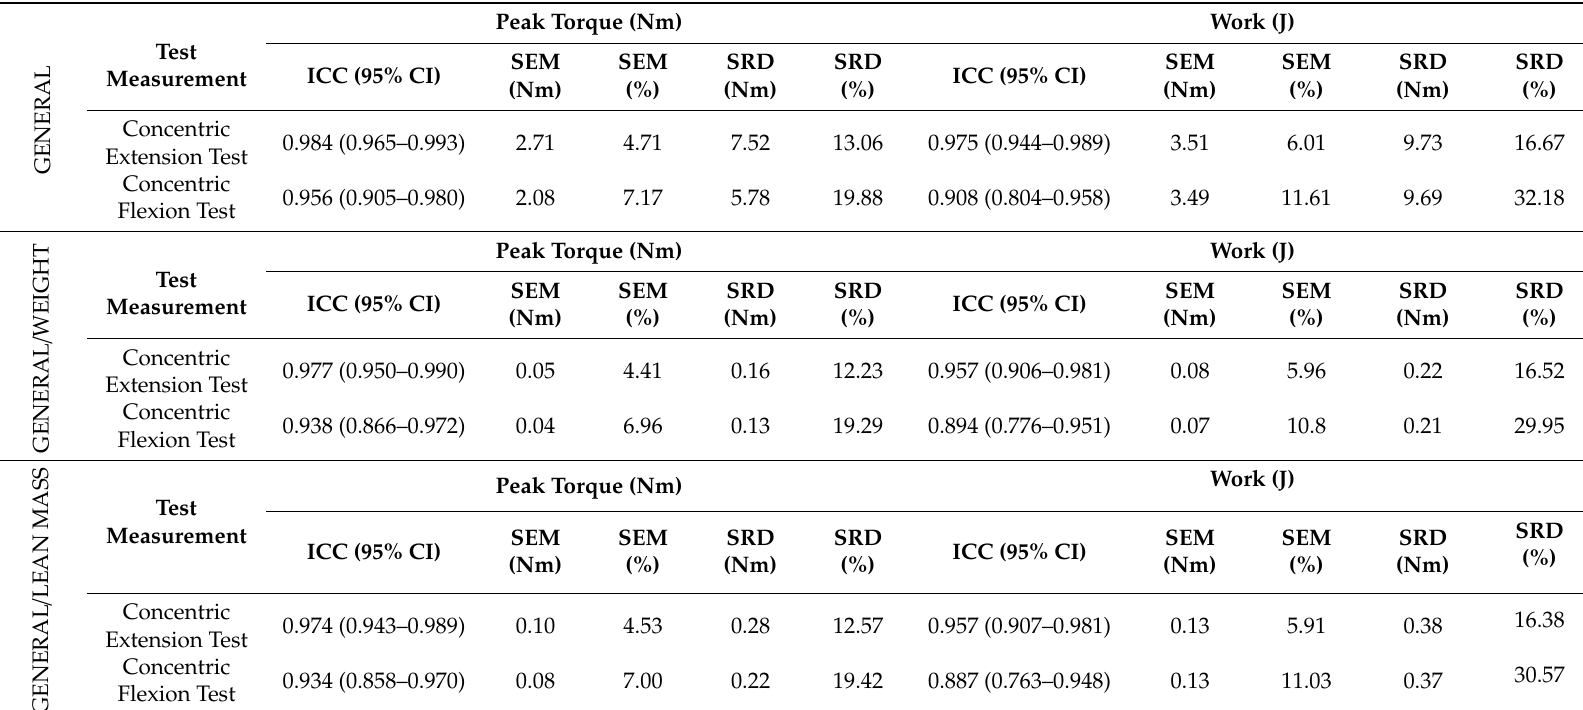
Table 3. Reliability of isokinetic concentric knee measurements ( n =